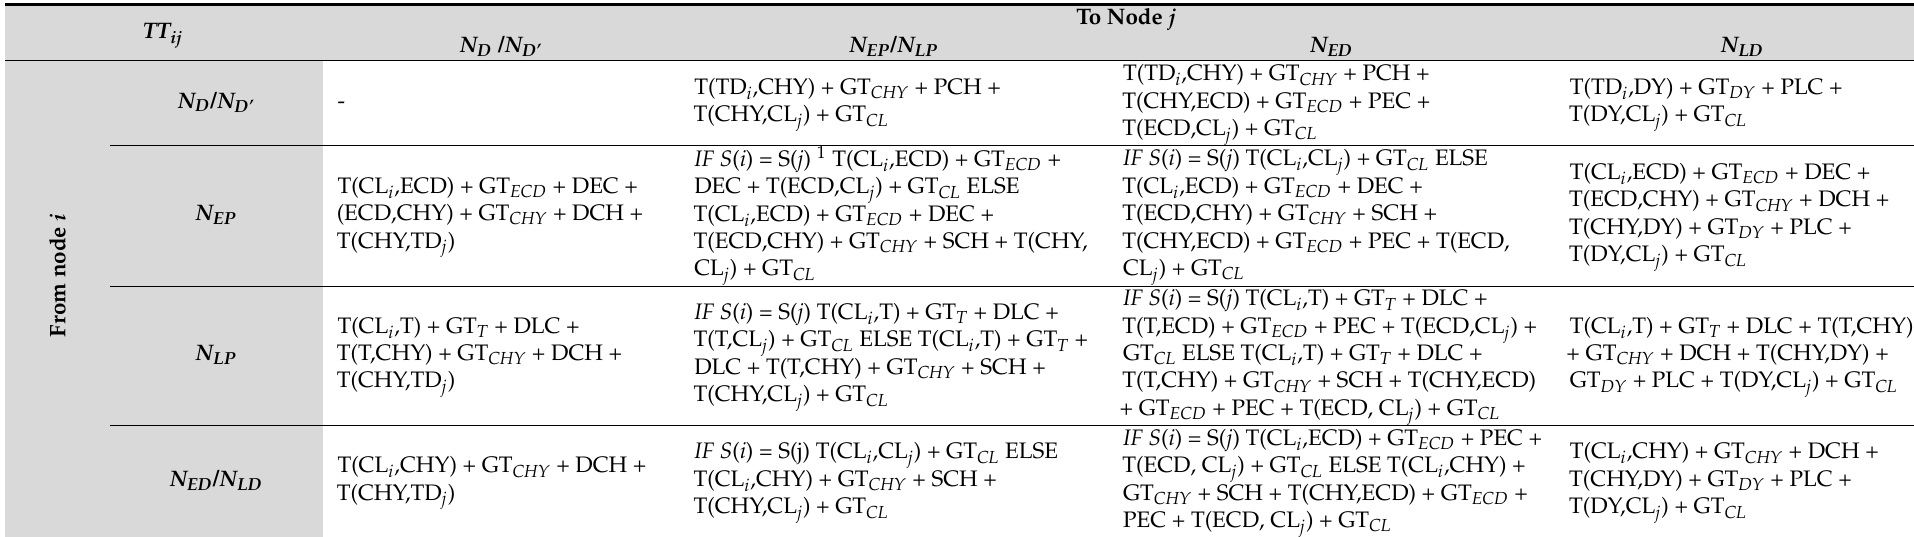
Table 2. Transfer Time on Arc ( i , j ) for Scenario